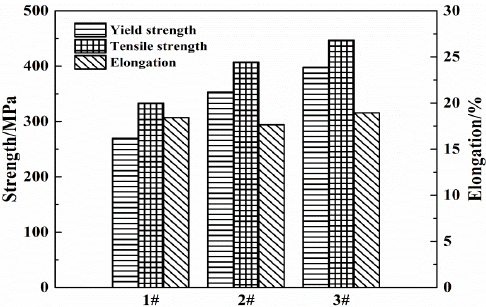
Figure 6. Mechanical properties (ED direction on ED – TD plane) of alloys with different Zn/Mg ratios.